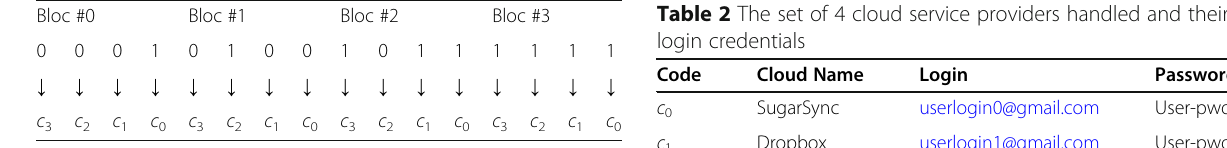
Table 2 The set of 4 cloud service providers handled and their